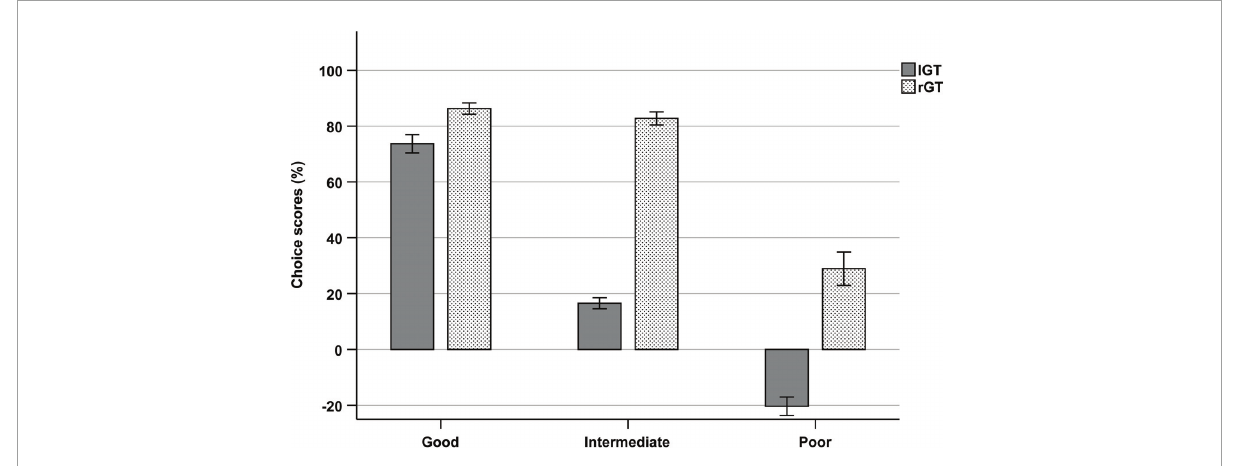
FIGURE6 Mean choice scores of each subgroup (good, intermediate, and poor) during trials 61–100 of the IGT and week 5 of the rGT.